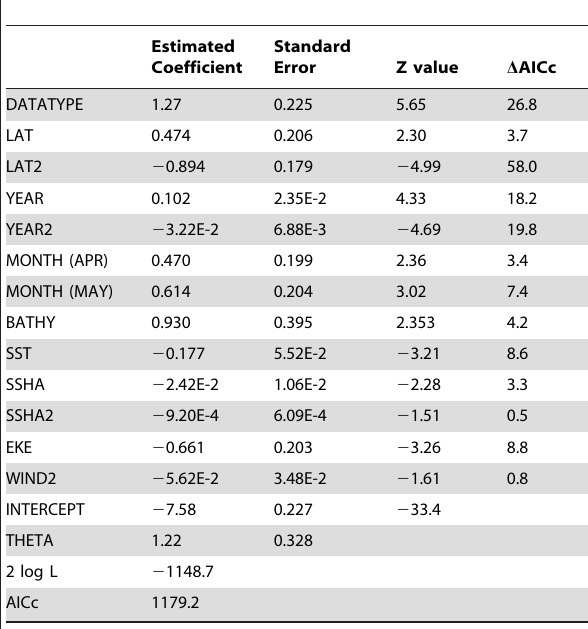
Table 2. Parameters and estimated coefficients of final bluefin tuna model.